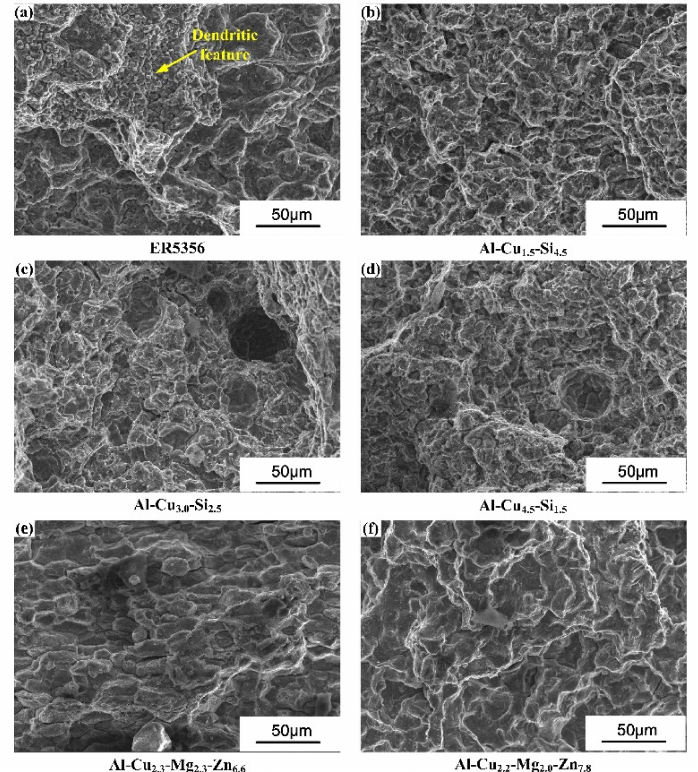
Figure 12. Fracturing surface: ( a ) The AA7075/ER5356 joint; ( b ) AA7075/Al-Cu 1.5 -Si 4.5